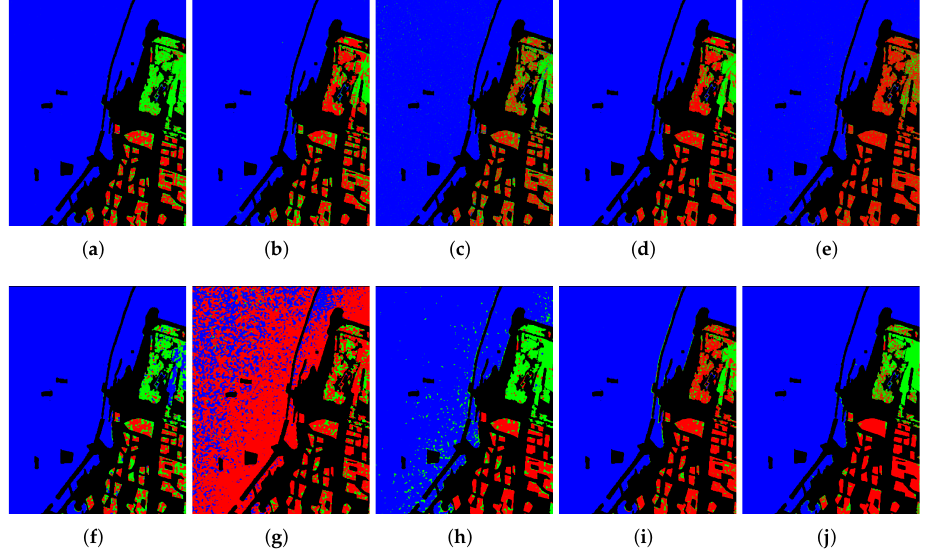
Figure 10. Classification results of Flevoland with different methods. ( a ) SVM. ( b ) Wishart.